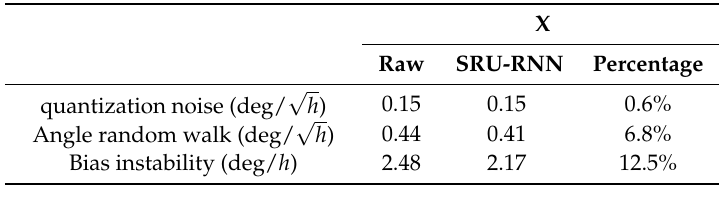
Table 4. Parameters of X-axis gyroscope results.